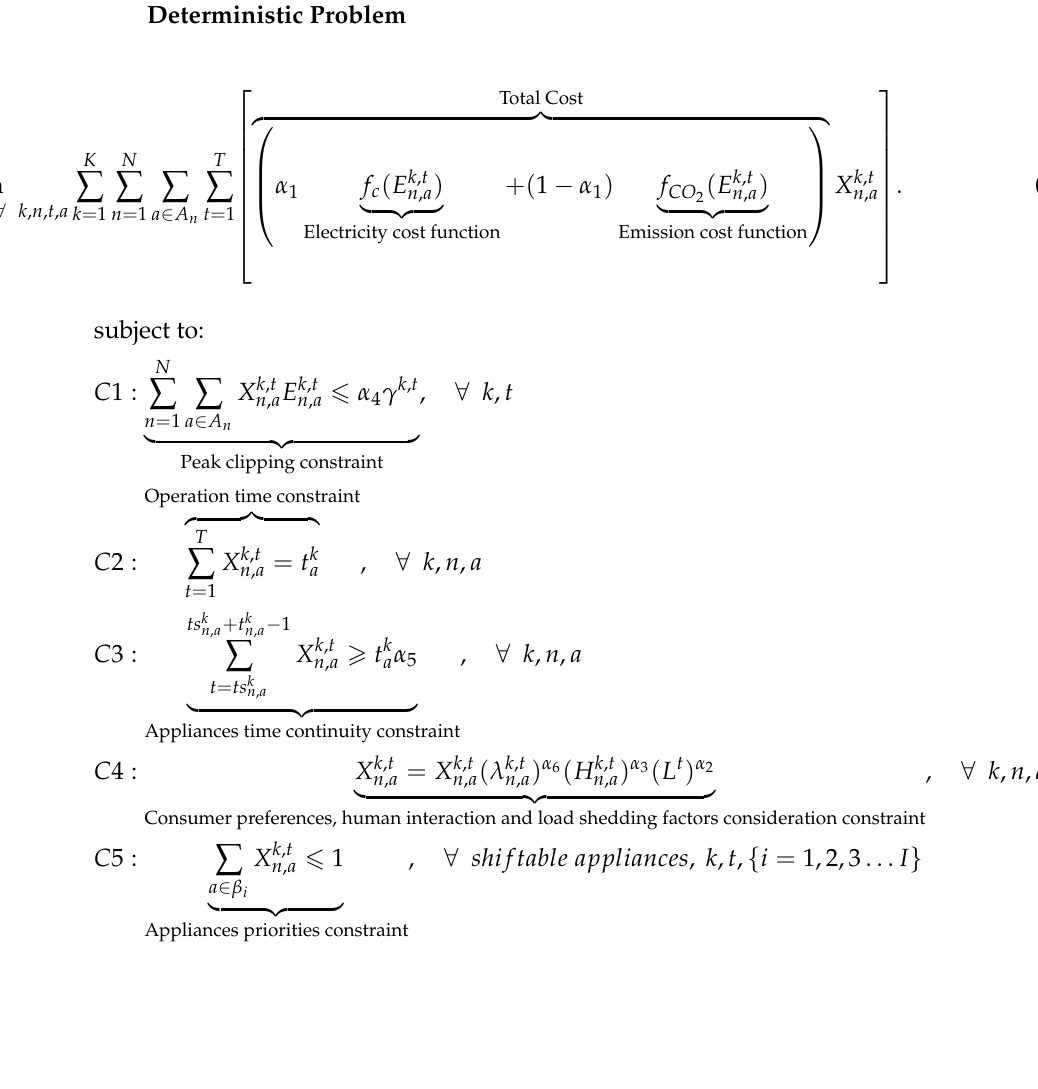
Figure 8. Residential compound